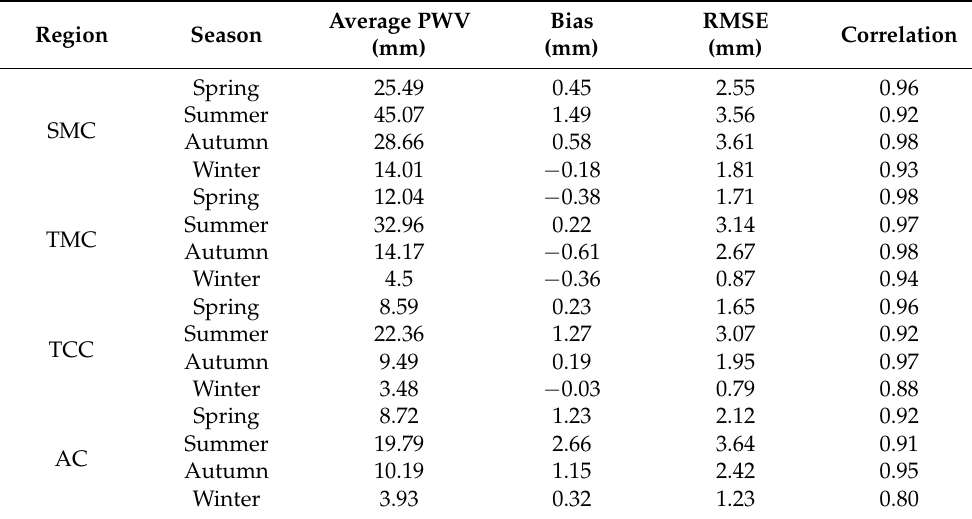
Table 2. Bias, RMSE, and correlation between the ERA5 PWV and GNSS PWV.